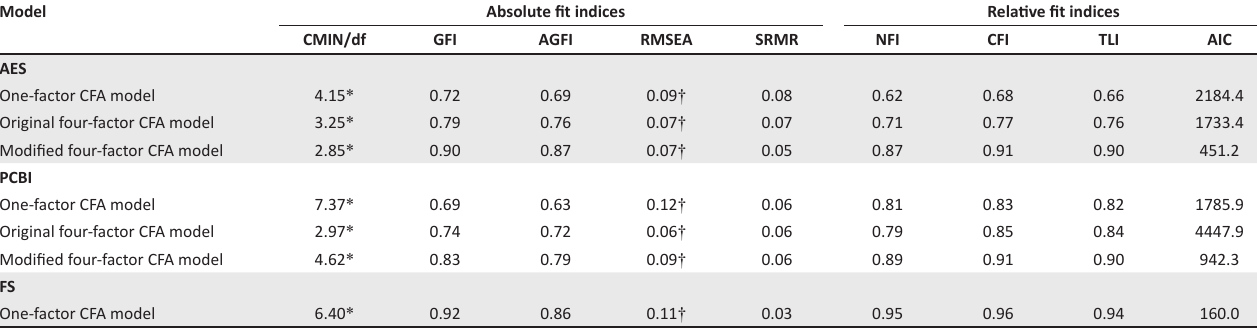
TABLE 2: Model fit statistics: Competing measurement models.